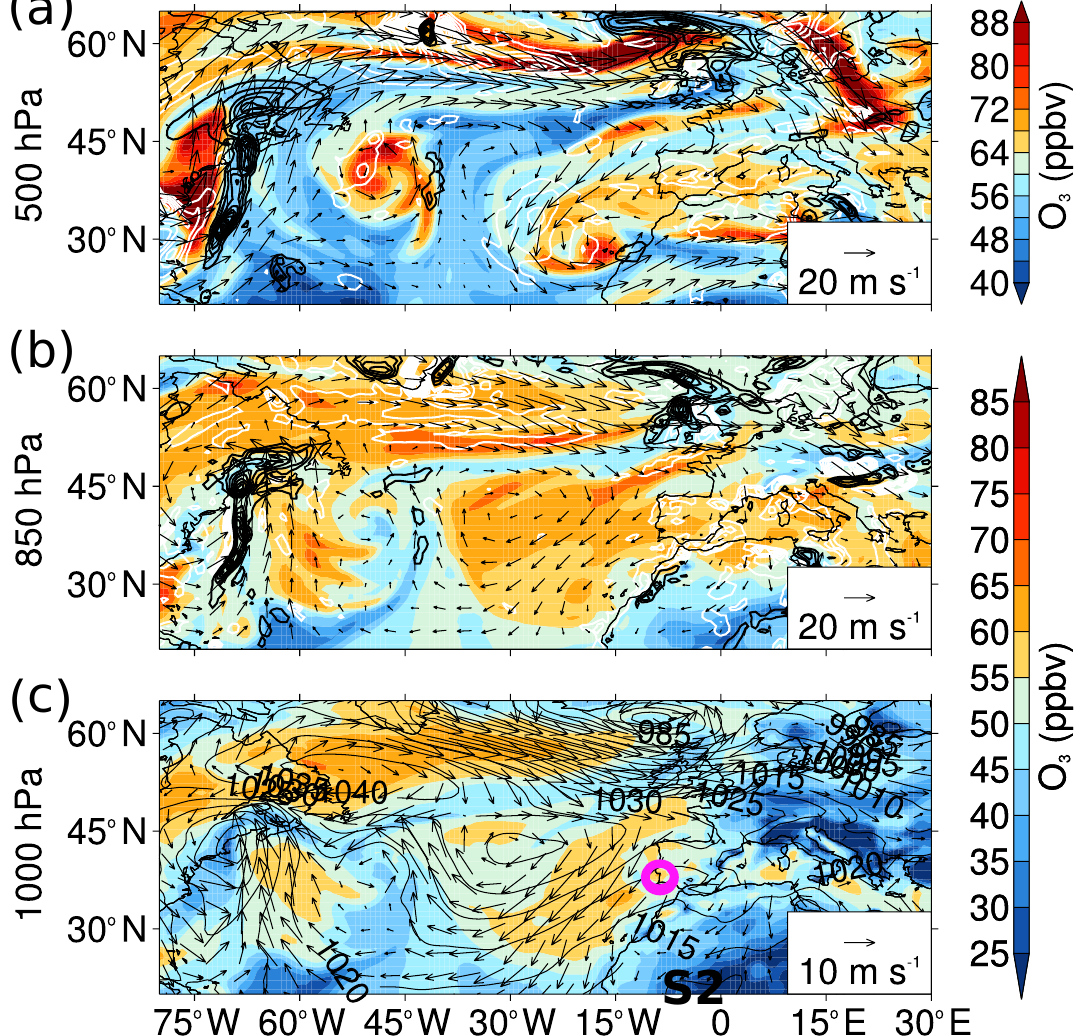
Figure 14. Similar to Fig. 13 except for the S2 cyclone ( c ; 23 ◦ N, 1 ◦ W) nearly 4 days later on the 17 March 2007 at 12:00UTC. High O 3 recorded at Monte Velho. O 3 (color; note different scales used for different levels) and horizontal winds (note magnitude of reference arrow changes) is shown on three levels: (a) 500hPa, (b) 850hPa, and (c) 1000hPa. In addition, MSLP ( c ; solid contours, 5hPa intervals) and ω ( a and b ; 5hPah − 1 contour intervals, black contours for positive values indicating ascent and white contours for descent) are